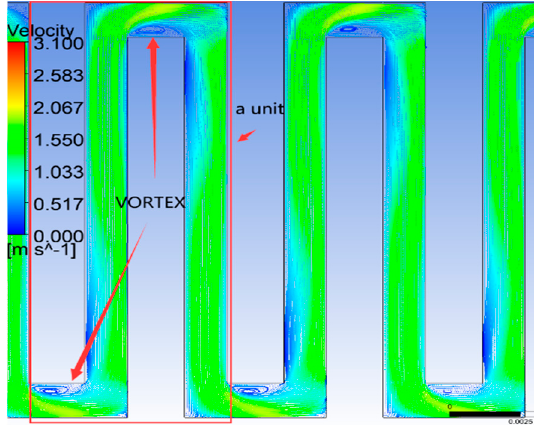
Figure 7. Streamlined diagram of the D emitter. Table 5. Vortex characteristics (in a channel